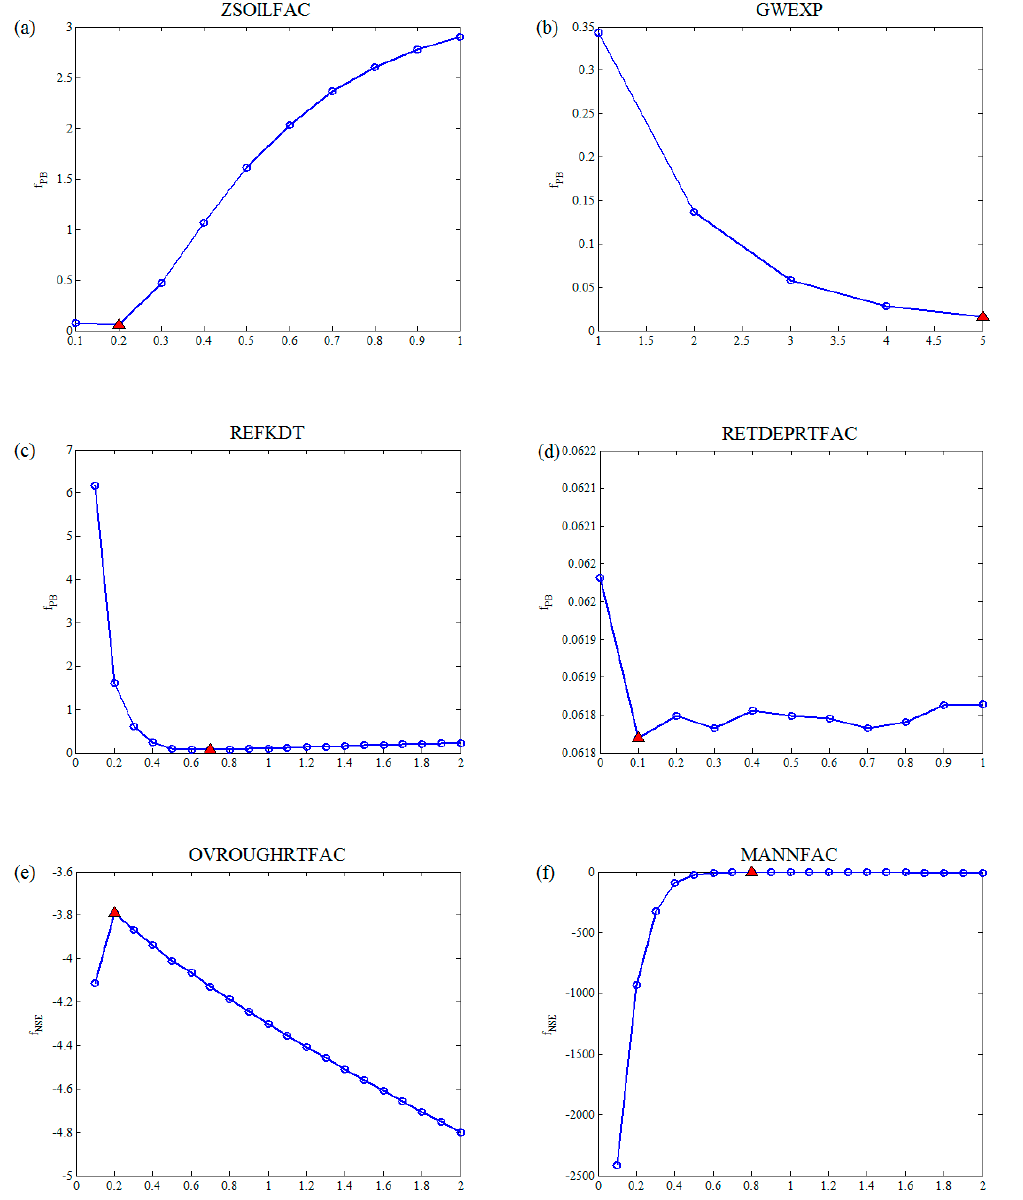
Figure 2. Calibration of ( a ) scaling factor on subsurface layer depth (ZSOILFAC), ( b ) the bucket model exponent of baseflow (GWEXP), ( c ) referring soil permeability (REFKDT), ( d ) multiplier on maximum retention depth (RETDEPRTFAC), ( e ) multiplier on Manning’s roughness for overland flow (OVROUGHRTFAC) and ( f ) multiplier on Manning’s roughness for channel (MANNFAC), where the red triangle in each figure represents the optimum